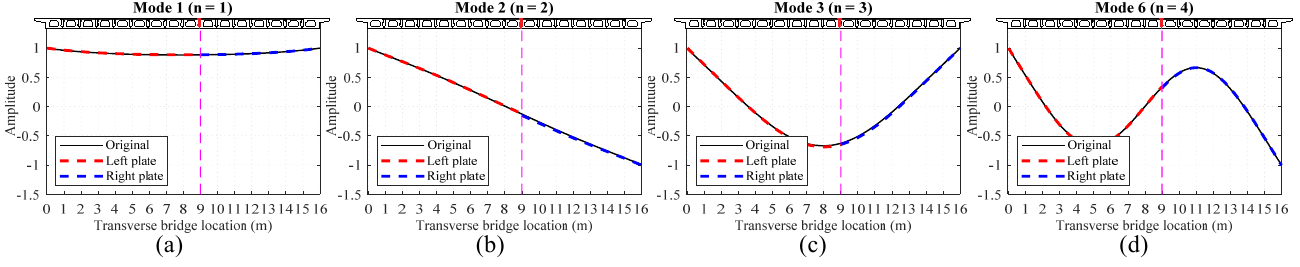
Figure 9. Comparison of the first four transverse modal shapes: hinge position η = 9 m: ( a ) Mode 1, n = 1; ( b ) Mode 2, n = 2; ( c ) Mode 3, n = 3; ( d ) Mode 6, n = 4.